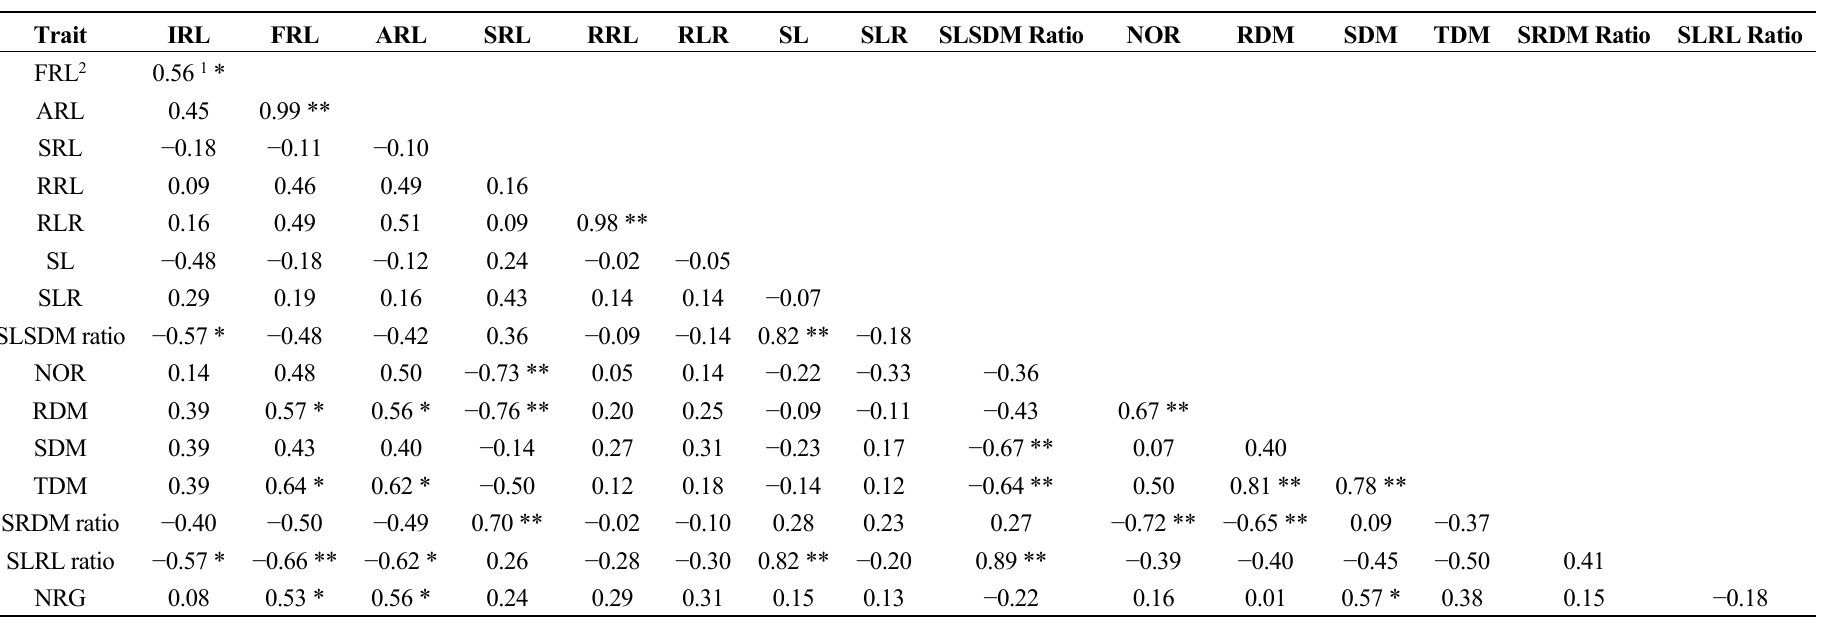
Table 5. Pearson correlation coefficients among 15 seedling traits of 14 maize inbred lines in six aluminum concentrations ( n = 84).